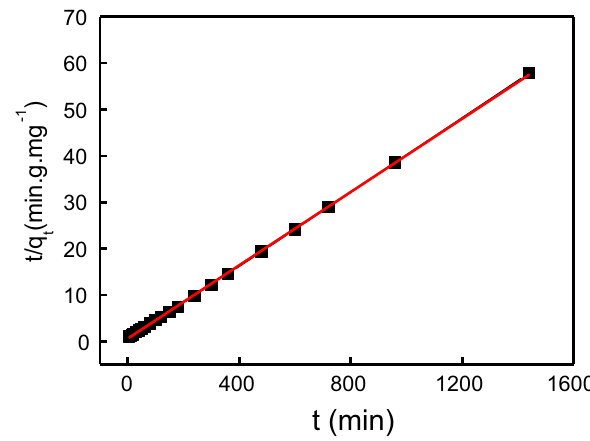
Fig. 5 Pseudo-second-order kinetics plots for the adsorption of Co(II) onto the chelating resin